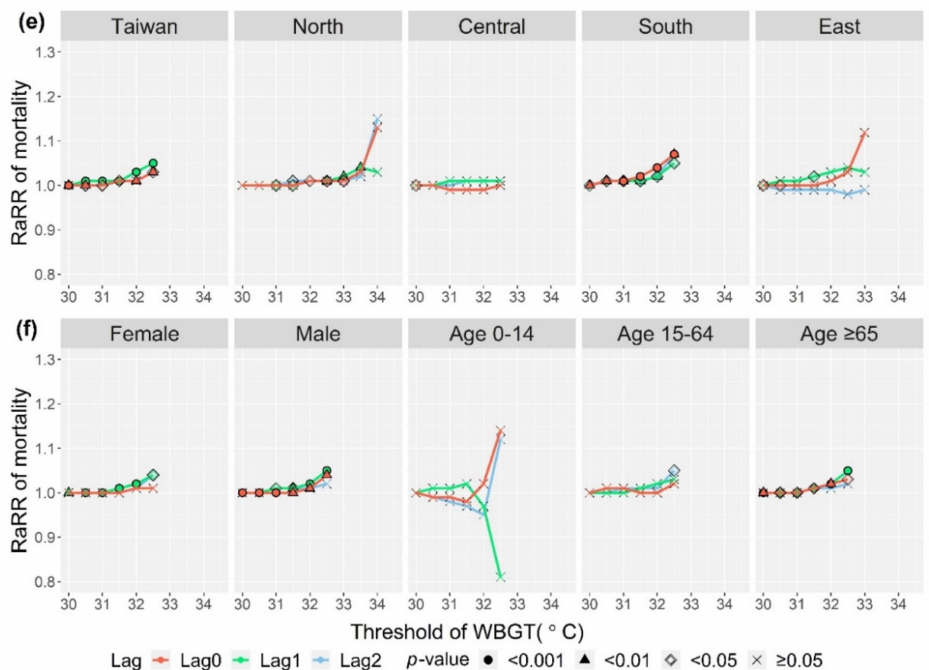
Figure 2. Reference-adjusted risk ratios (RaRRs) of heat-related emergency visits, heat-related hospital visits, and all-cause mortality at different WBGT threshold candidates for the whole of Taiwan and different sub-regions ( a , c , e ), and different sex and age ( b , d , f ). p -values are those for the corresponding relative risks at that threshold